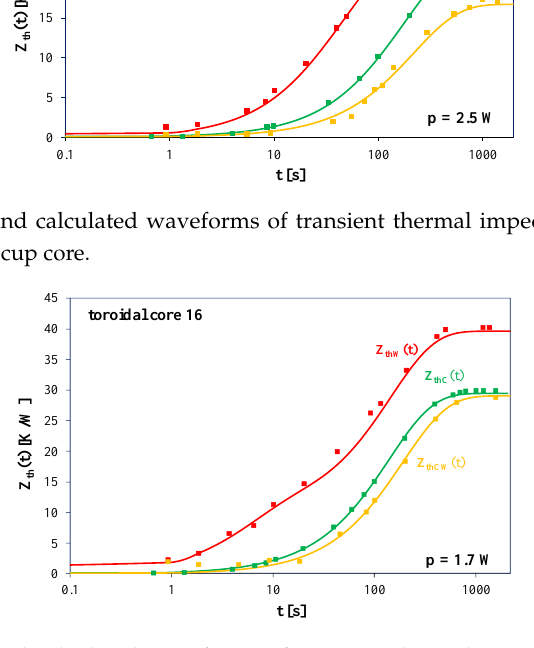
Figure 11. Measured and calculated waveforms of transient thermal impedances of the inductor containing the toroidal core 16.